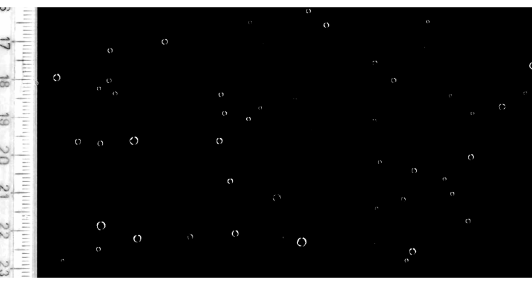
Figure 8. Raindrops collected on a plastic